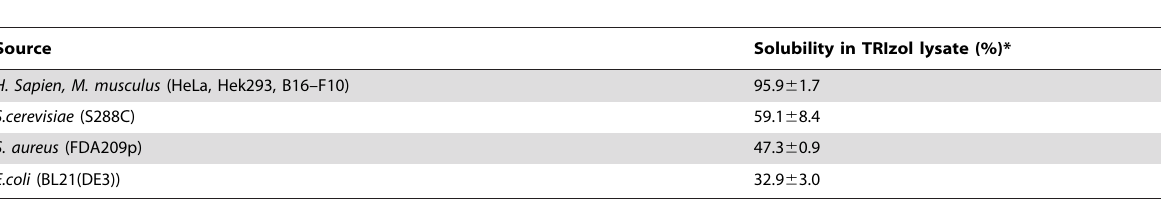
Table 1. Solubility of denatured and nucleic acid-free total cell proteins in pure water.